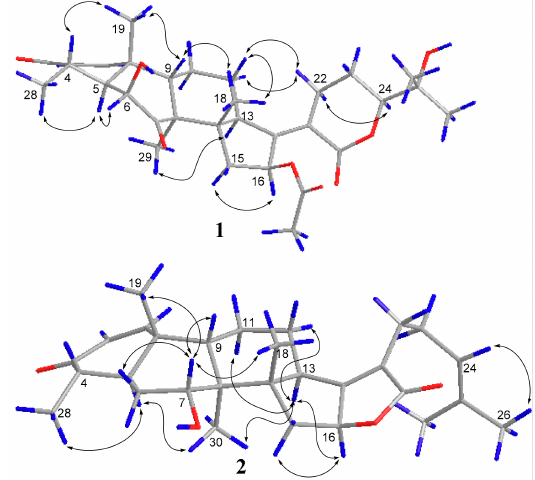
Figure 3. The key ROESY correlations of compound 1 and 2